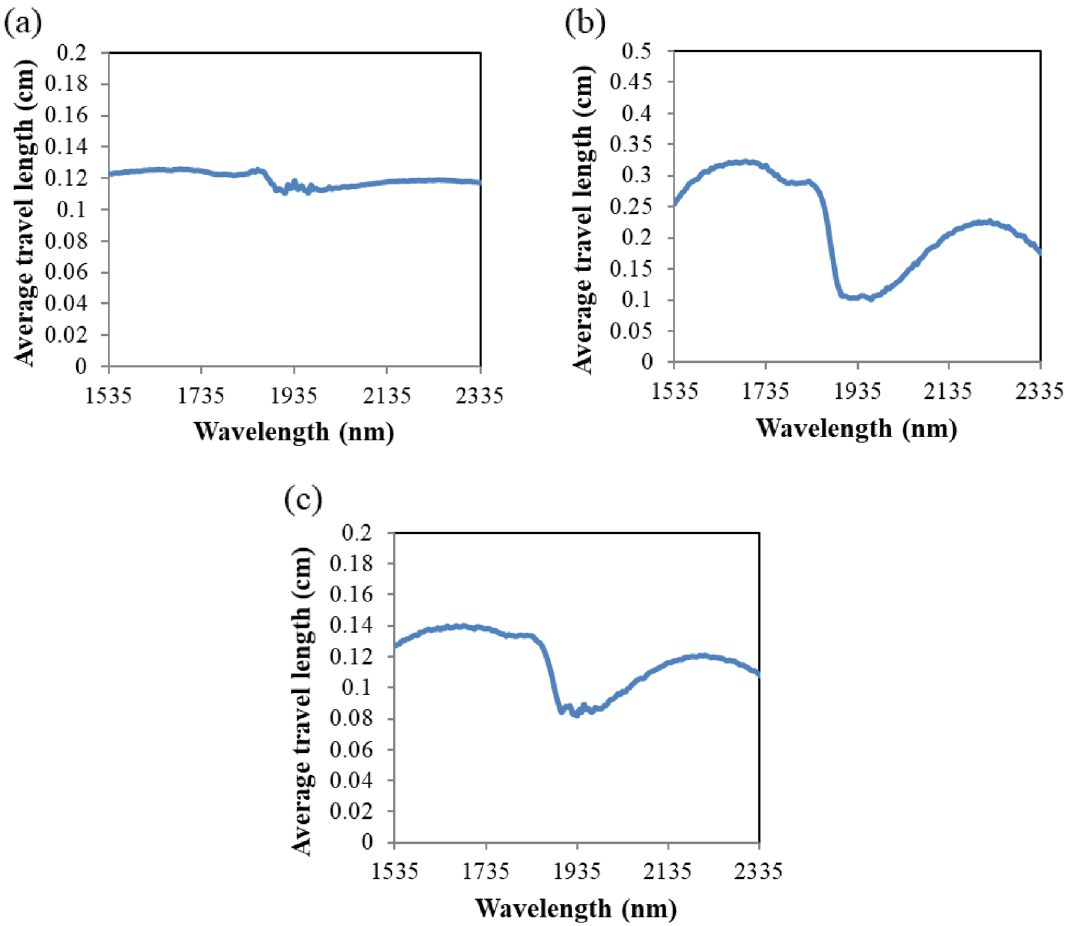
Figure 5. Average photon travel length along the wavelength for ( a ) transmission, ( b ) transflection and ( c ) reflection optical